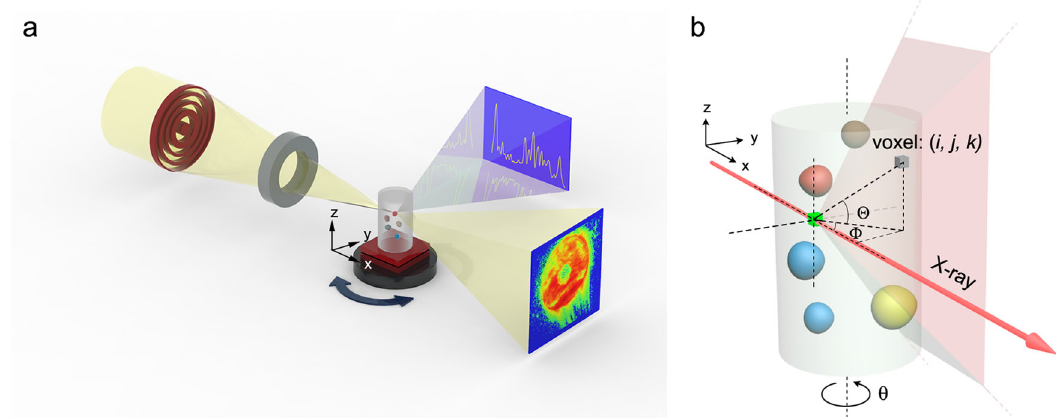
Fig. 1 Fluorescence x-ray tomography setup at the Hard X-ray Nanoprobe at NSLS-II. a a monochromatic x-ray beam is focused using a Fresnel zoneplate, together with a central beam stop (not shown) and an order-sorting aperture. The transmitted scattering pattern and fl uorescence signals are collected simultaneously. Raster scanning is performed to produce a 2D XRF projection image, and tomography measurement is carried out by collecting a series of 2D XRF images as the sample is rotated about the vertical axis, perpendicular to the x-ray beam. b Fluorescence x-rays emitted from an arbitrary point along the incidence x-ray beam, represented by a green voxel. Only a fraction of fl uorescence x-rays is captured by a detector with a given solid angle (represented by a pink shape), encoding the absorption through a 3D local region of the sample de fi ned by the detector solid angle (i.e., traversed region). A gray cube represents a voxel within this traversed region, where the absorption is corrected. The traversed region changes with the orientation and position of the